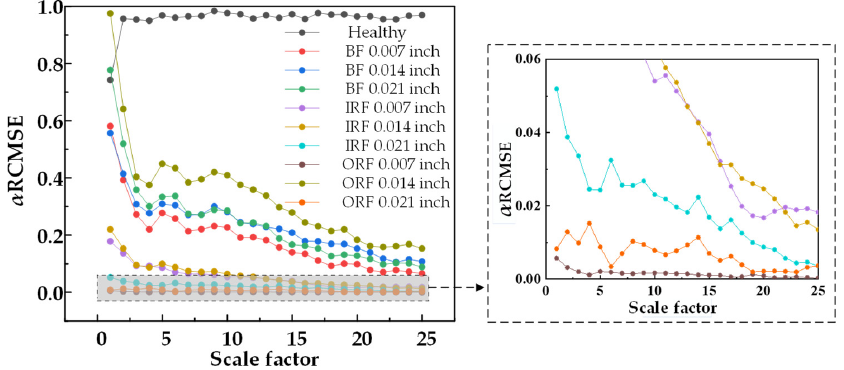
Figure 6. RCMDE entropy values of 25 scale factors under different damage degrees.